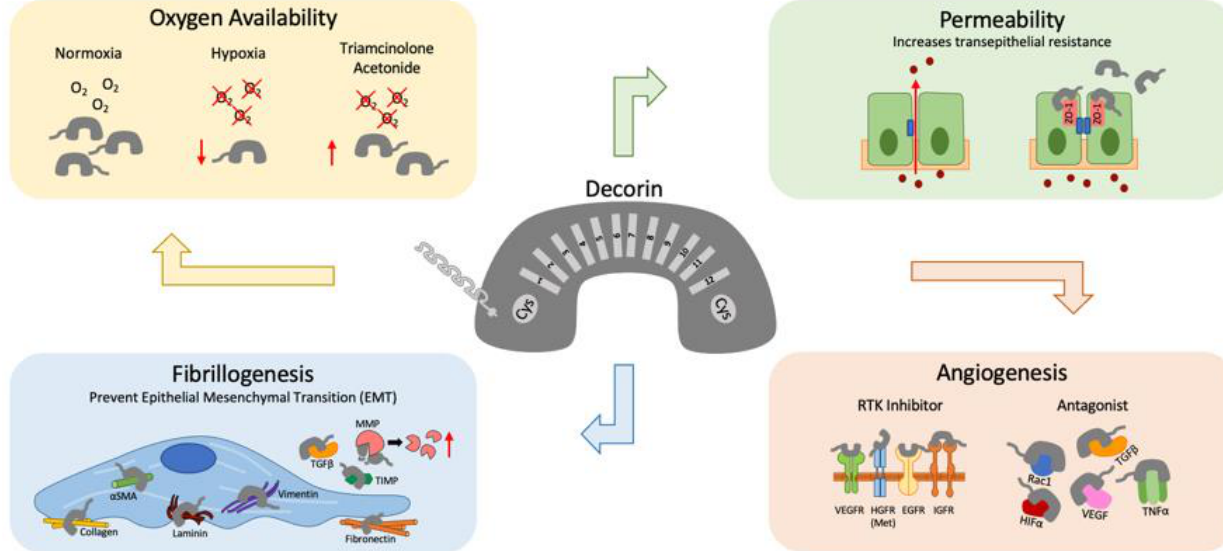
Figure 2. Decorin’s versatility in the retina. The class I horseshoe-shaped SLRP, decorin has a protein core made of 12 leucine rich repeats (LRRs) which are flanked by cysteine rich residues. Their GAG side chains are typically chondroitin/dermatan sulfate. Under hypoxic conditions, decorin levels decreased, which can be rescued with triamcinolone acetonide. Barrier permeability can be compromised during high glucose conditions. Decorin has been reported to increase transepithelial resistance, and increase tight junction proteins such as occludin and Zonula Occludens-1 (ZO-1). Decorin can also regulate angiogenesis by exhibiting both pro- and anti-angiogenic capabilities. Decorin is a pan-receptor tyrosine kinase (RTK) inhibitor and has been shown to bind and inhibit Rac1, HIFα, VEGF, TGFβ, and TNFα. Decorin can also reduce proteins involved in fibrillogenesis such as collagen, αSMA, laminin, vimentin and fibronectin. Furthermore, decorin activate matrix metalloproteinases (MMPs) and reduce tissue inhibitors of metalloproteinases (TIMPs) to help prevent epithelial mesenchymal transitioning (EMT).